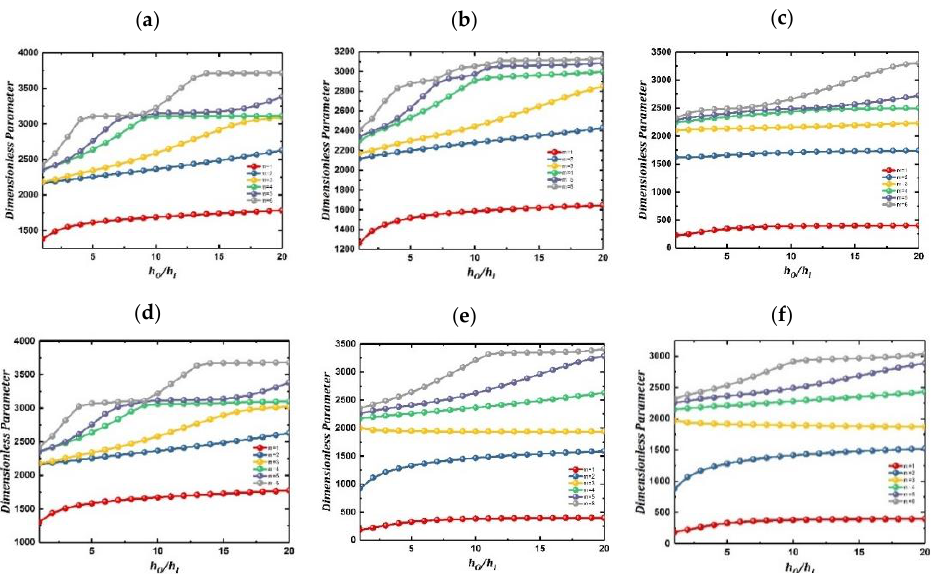
Figure 6. Variation of frequency parameter Ω versus thickness for an LCDCSS with classical boundary conditions. ( a ) CC-CC; ( b ) SS-SS; ( c ) FF-FF; ( d ) CS-CS; ( e ) CF-CF; ( f ) SF-SF.